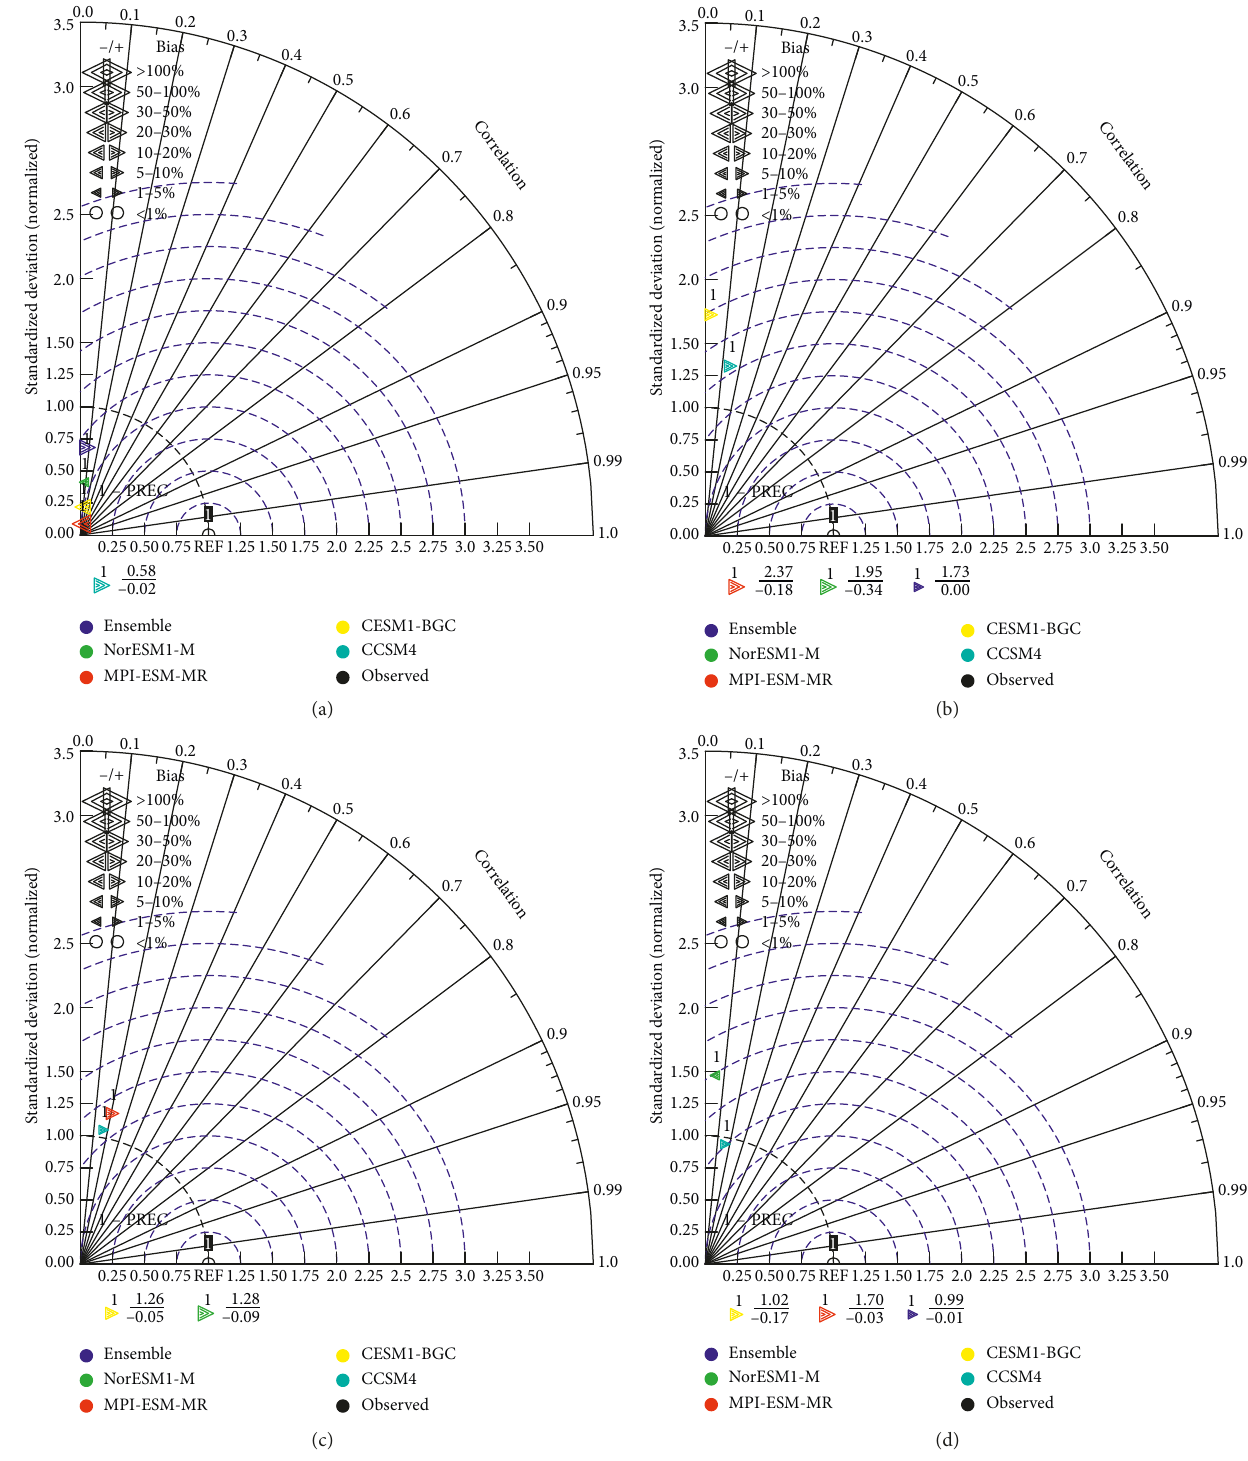
Figure 11: Taylor diagram for the Soudano-Sahel showing the normalized standard deviation, the correlation, and the RMSE representing the variability, pattern, and errors, respectively, within the models and the reference data: DJF (a); MAM (b); JJA (c); SON